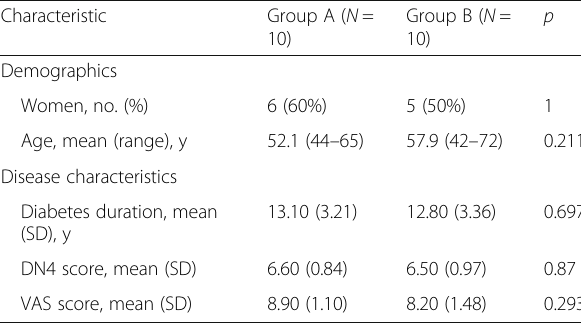
Table 1 Participants ’ baseline